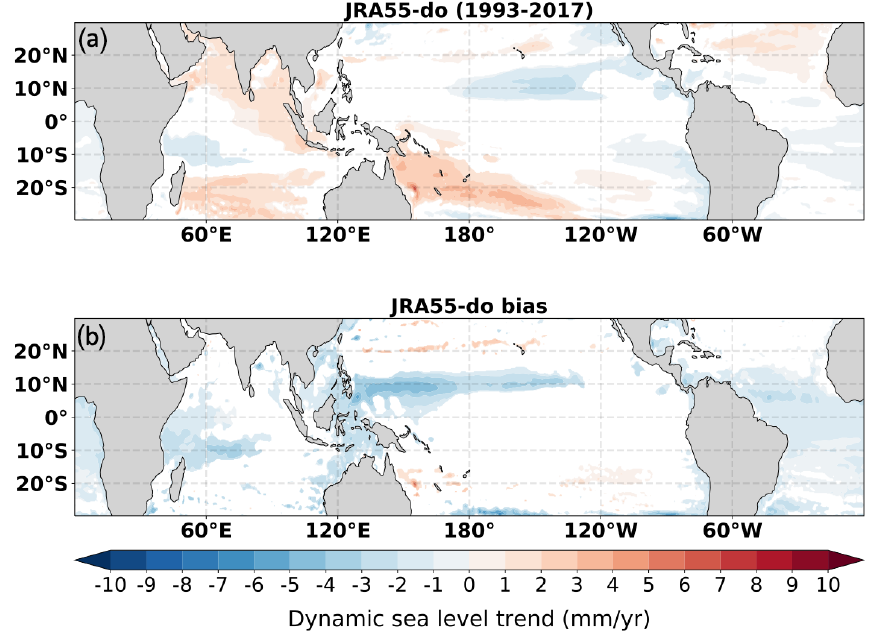
Figure 14. The DSL (a) trend and (b) trend bias during 1993–2017 with 99% confidence (shading) in the JRA55-do-forced simulation.